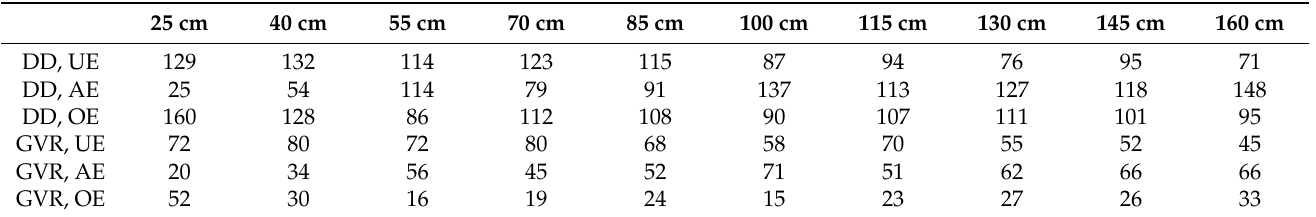
Table 2. The number of underestimates, accurate estimates, and overestimates at each investigated